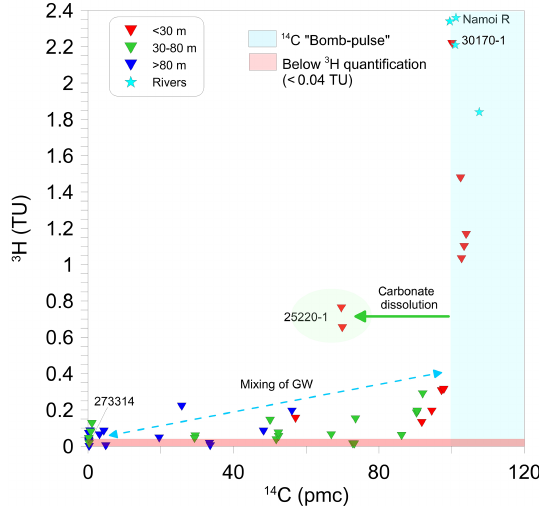
Figure 7. 36 Cl / Cl ( × 10 − 15 ) vs. 14 C (pmc). The colour gradient represents the mixing between the two major sources: surface water recharge (blue is modern) and the GAB (brown is old). The shaded yellow ellipse encompasses the two outliers where the geochemistry is being influenced by proximity to the Napperby Formation. The shaded pink ellipse is sample 25327-3, located in the irrigation